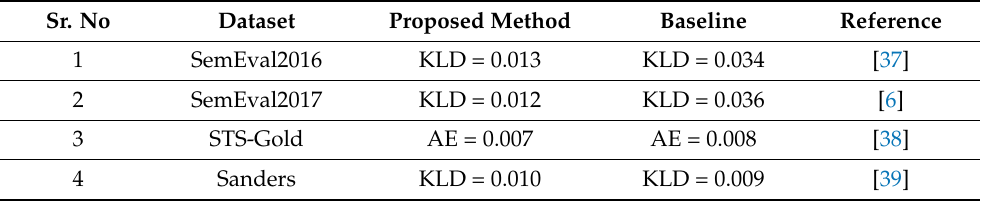
Table 11. Comparison of proposed framework and baseline approaches.